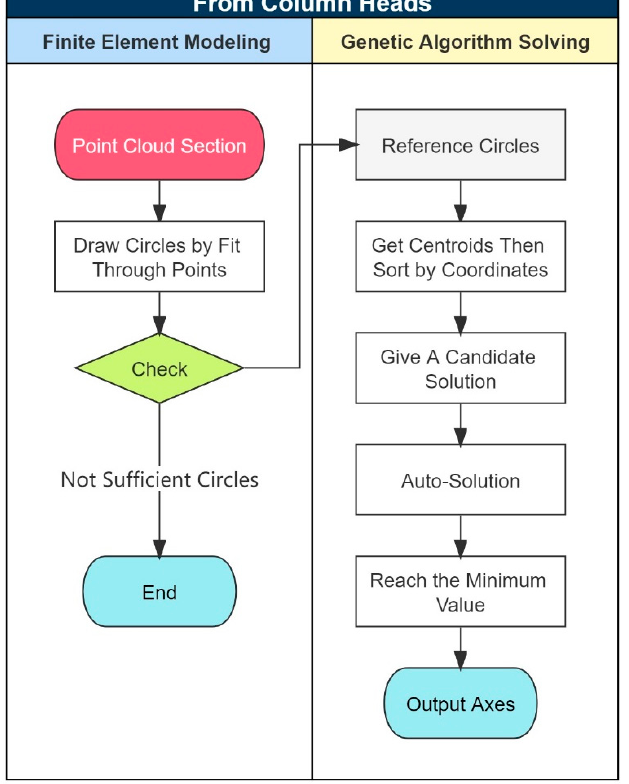
Figure 1. The Auto-generation